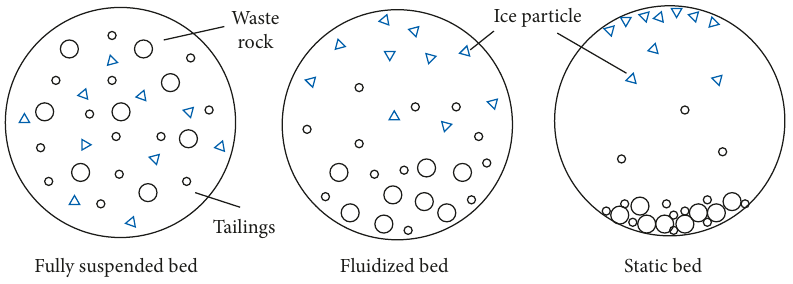
Figure 3: Three flow regime of CLS backfill slurry.